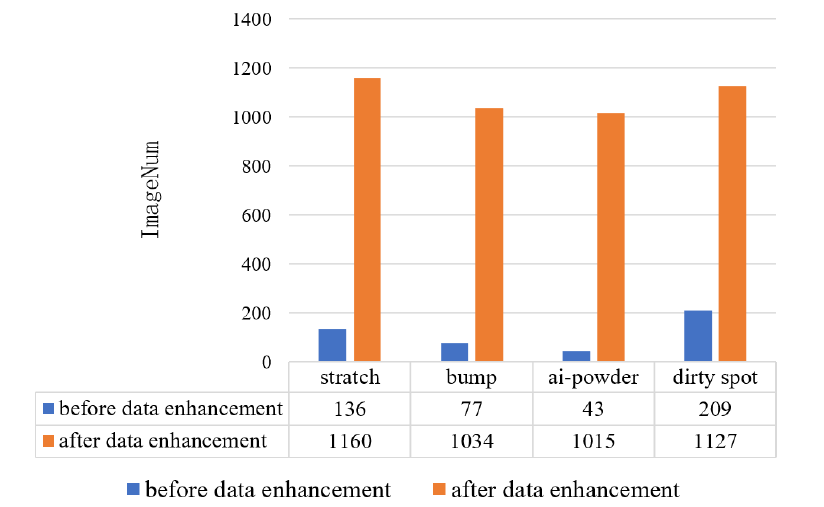
Figure 9. Comparison of surface defect data of aluminum profiles.